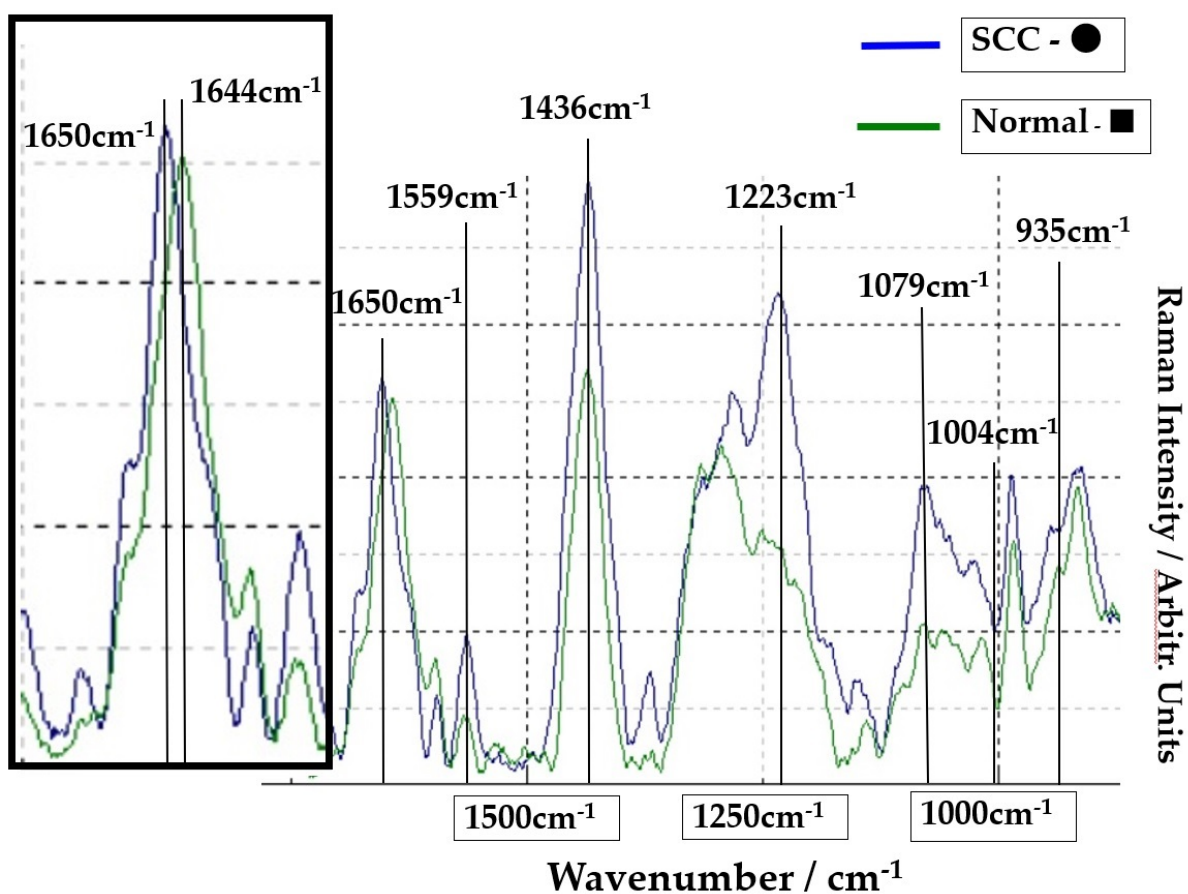
Figure 2. Comparison of spectra at point ● in SCC area (blue line) and at point ■ in normal area (green line). The left frame is the expansion of the peak of 1650 cm − 1 .